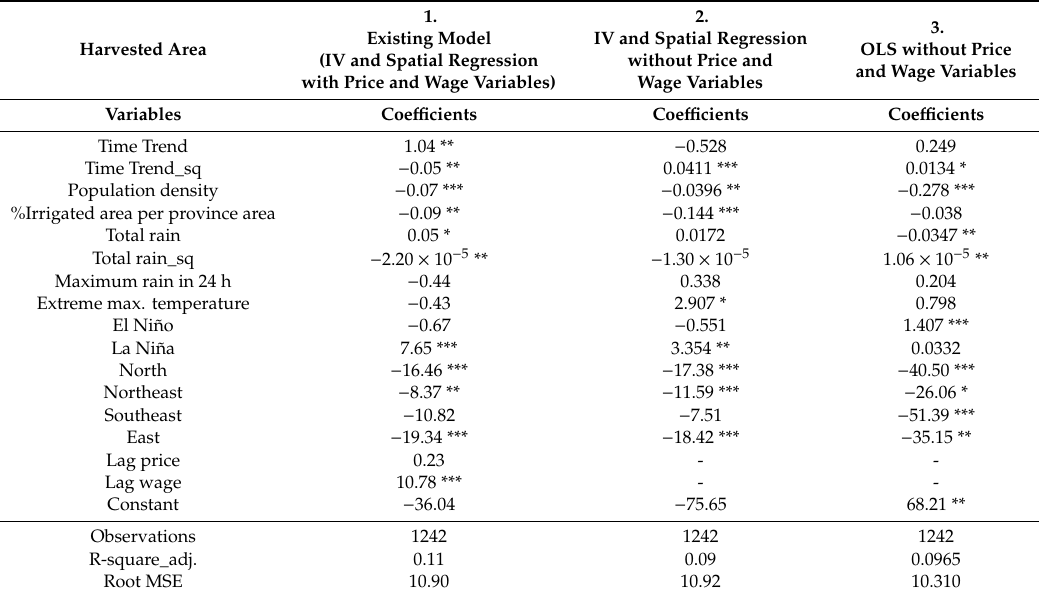
Table A3. Comparison of harvested area models with and without price and wage variables.